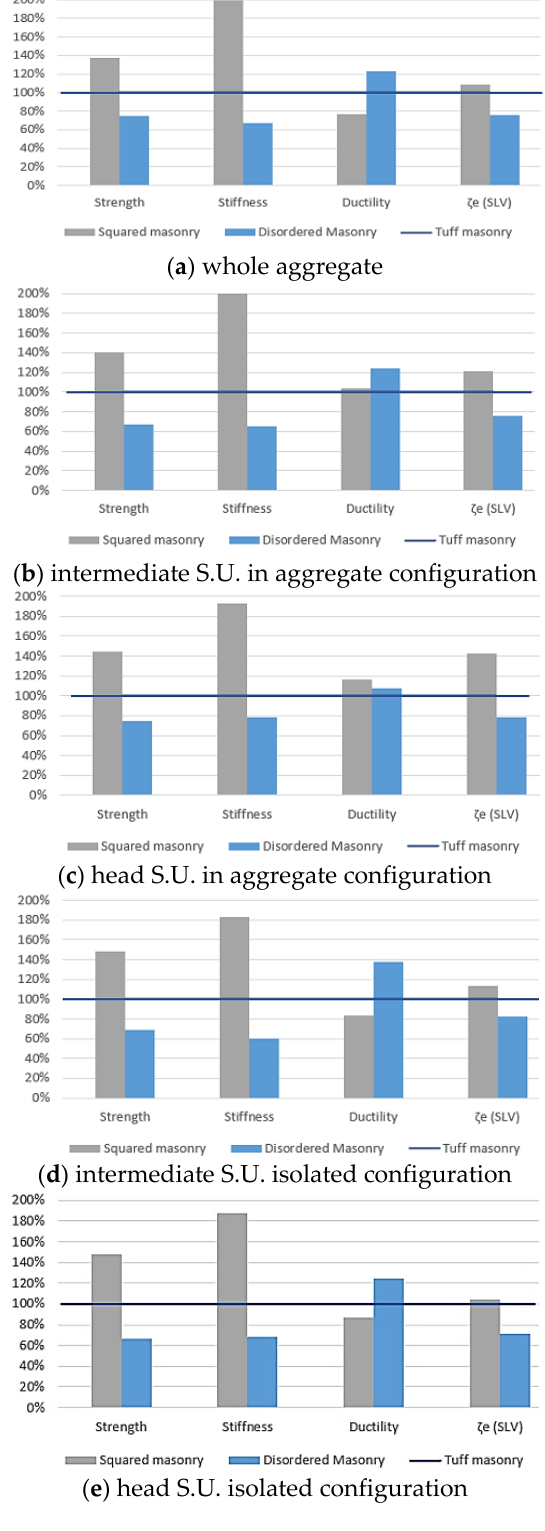
Figure 13. Influence of masonry types on the seismic behaviour of the whole aggregate and the monitored S.Us.